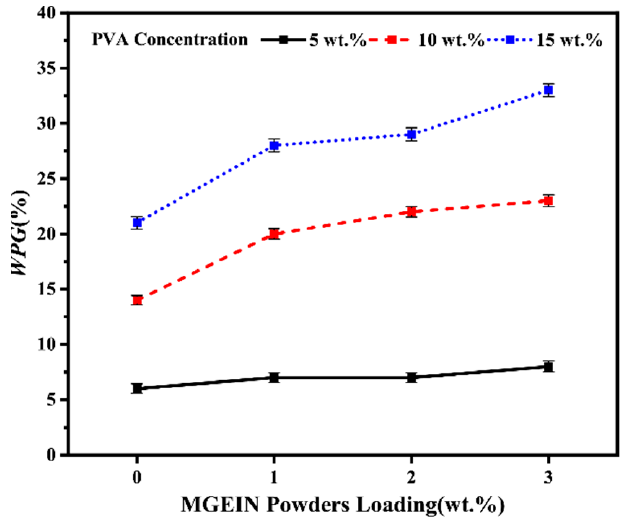
Figure 4. Weight percent gain of Gr/PVA impregnated modified veneers.